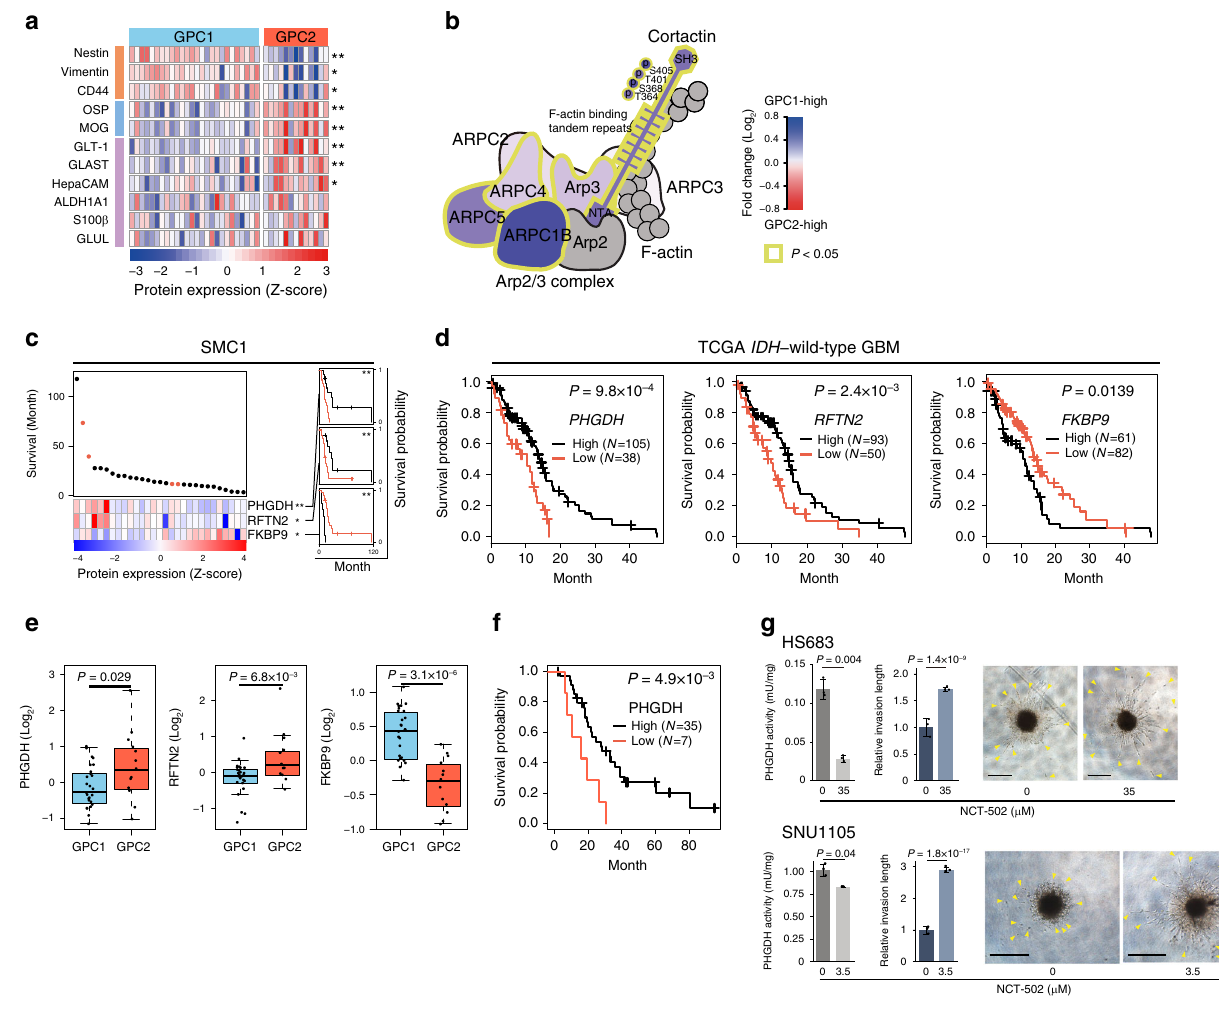
Fig. 4 GPC2-associated PHGDH predicts a favorable prognosis in IDH wild-type GBM. a Differential expression of protein markers for NSCs (orange), oligodendrocytes (blue), and astrocytes (purple) between proteomic subtypes. * P < 0.05, ** P < 0.001; two-sided unpaired Student ’ s t -test. See Supplementary Data 3 for exact P -values. b The cortactin-Arp2/3 complex is elevated in GPC1 tumors. The gray color indicates proteins with no available protein expression data. P -values were calculated by two-sided unpaired Student ’ s t -test. c Prognostic biomarker proteins in IDH wild-type GBM. Deceased and surviving patients are denoted by black and red dots, respectively. * P < 0.05, ** P < 0.01; univariate Cox regression test. Kaplan – Meier (KM) survival curves for IDH wild-type GBM patients ( N = 29) in the SMC1 cohort were shown on the right for each of the three proteins (black: high expression, red: low expression). ** P < 0.01; two-sided log-rank test. d Kaplan – Meier (KM) survival curves. Patients were classi fi ed by the optimal gene expression thresholds reported by Uhlen et al. 28 . P -values were calculated using the two-sided log-rank test. e Box-jitter plots for the abundance of the indicated proteins. The description of the box-and-whisker plots is the same as in Fig. 3b. Statistical signi fi cance of the downregulation of favorable markers (PHGDH and RFTN2) and upregulation of an unfavorable marker (FKBP9) was evaluated by Student ’ s t -test (one-sided unpaired). The number of samples for GPC1 and GPC2 is 26 and 13, respectively. f KM survival curves for PHGDH-high vs. low patients in the SMC-TMA cohort. Patients were classi fi ed as described in d . P -values were calculated as in d . g PHGDH activity (left), relative invasion lengths (middle), and representative images of 3D invasion (right) of the indicated tumor spheres after treatment of vehicle (DMSO) or NCT-502 for 48 h at the indicated concentrations. Two-sided unpaired Student ’ s t -test was used to compare PHGDH activity. Two-way ANOVA was used for the comparison of relative invasion length between treatment groups. Error bars indicate ±SD, N = 3. Arrowheads indicate invasive fronts. Scale bar: 500 μ m. Source data are provided as a Source Data fi (Fig. 4e). However, GPC subtypes did not directly show a sig- ni fi cant difference in prognosis (two-sided Log-rank test P = a functional role for PHGDH in limiting tumor aggressiveness. 0.0548). Intriguingly, NCT-502, a chemical inhibitor of PHGDH, signi fi cantly increased invasion of tumor spheres (Fig. 4g) derived from PHGDH-active GBM cell lines (Supplementary Fig. 4c, d and Supplementary Data 5) into 3D matrix. Conversely, PHGDH overexpression in PHGDH-de fi cient GBM cell lines decreased prolong patient survival by suppressing tumor invasion via its